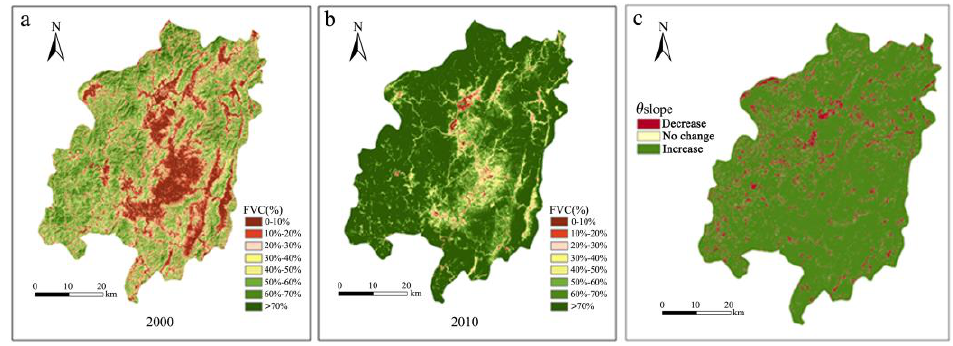
Figure 2. FVC in the 2000 ( a ) and 2010 ( b ) and the fractional vegetation cover change in Changting during 2000–2010 ( c ). FVC represents fractional vegetation cover. Table 2. The percentage and rate of different types of FVC change of Changting during 2000–2010. Type of FVC Change Percentage of Each Change Type (%)